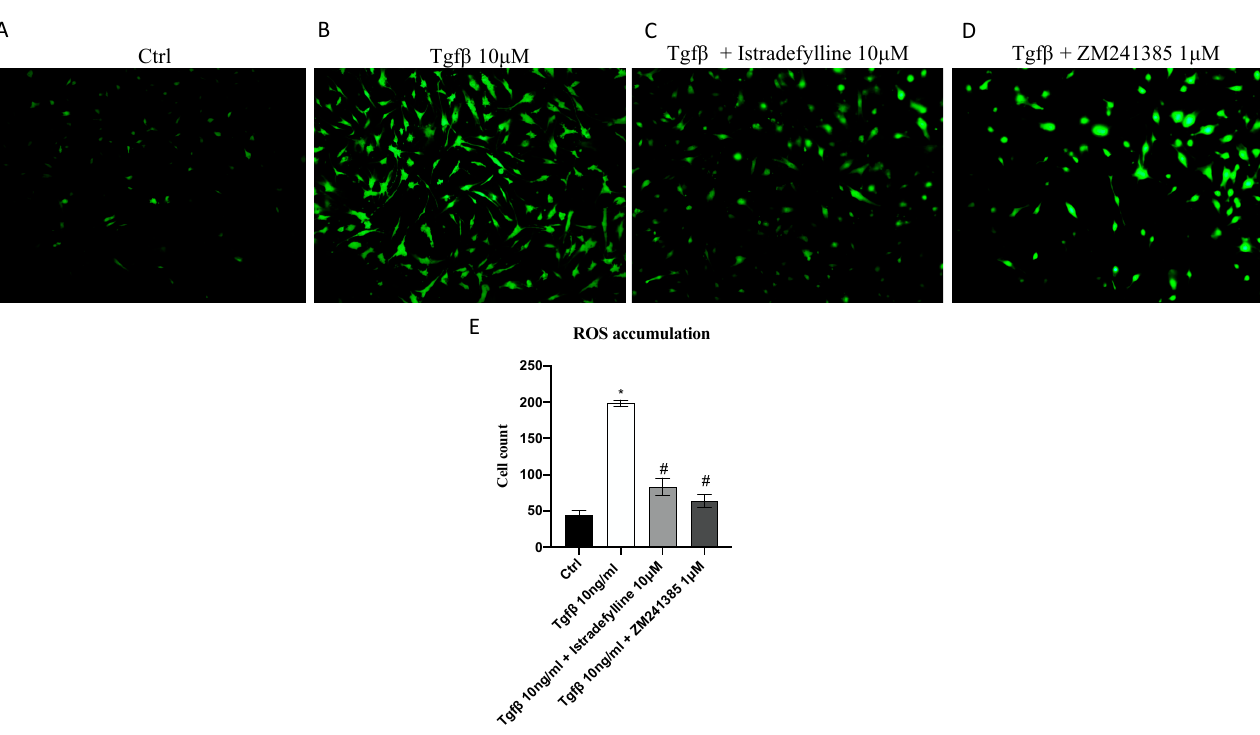
Figure 2. Intracellular ROS accumulation evaluated with a CM-H2DCFDA fluorescent probe in IM-HCF cells stimulated with TGF- β (10 ng/mL) alone and TGF- β followed by Istradefylline (10 µ M) or ZM241385 (1 µ M) for 24 h. Panel E shows the % of fluorescent cells/total cells. The data are expressed as means ± SDs of five experiments. * p < 0.05 vs. CTRL; # p < 0.05 vs. TGF- β . All images were captured at 10× magnification.